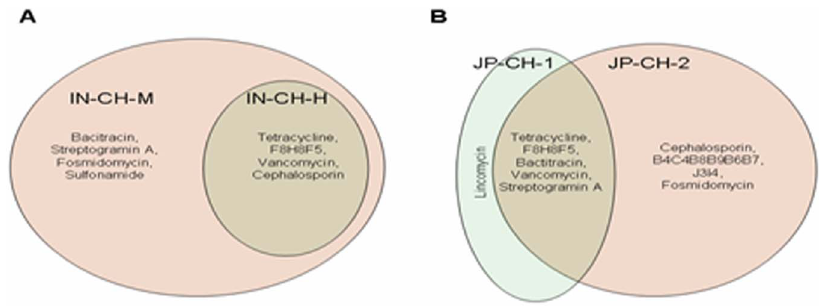
Figure 6. Comparison of identified antibiotic resistance genes in the gut microflora of (A) Malnourished Indian child (IN-CH-M) and Healthy Indian child (IN-CH-H) (B) Japanese children (JP-CH-1 and